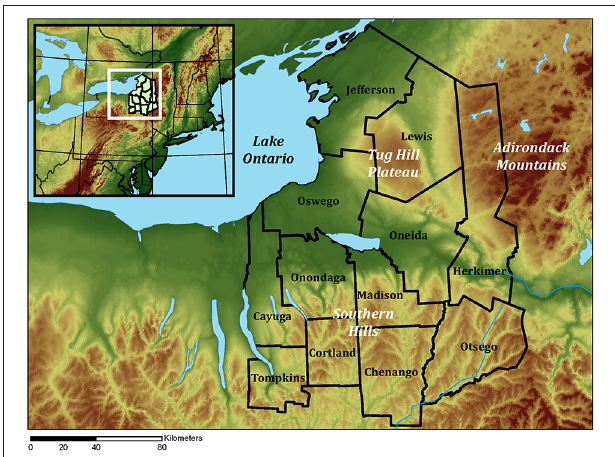
FIGURE 1 | Central New York study area. Included are the county names (black text) and prominent regions (white text).